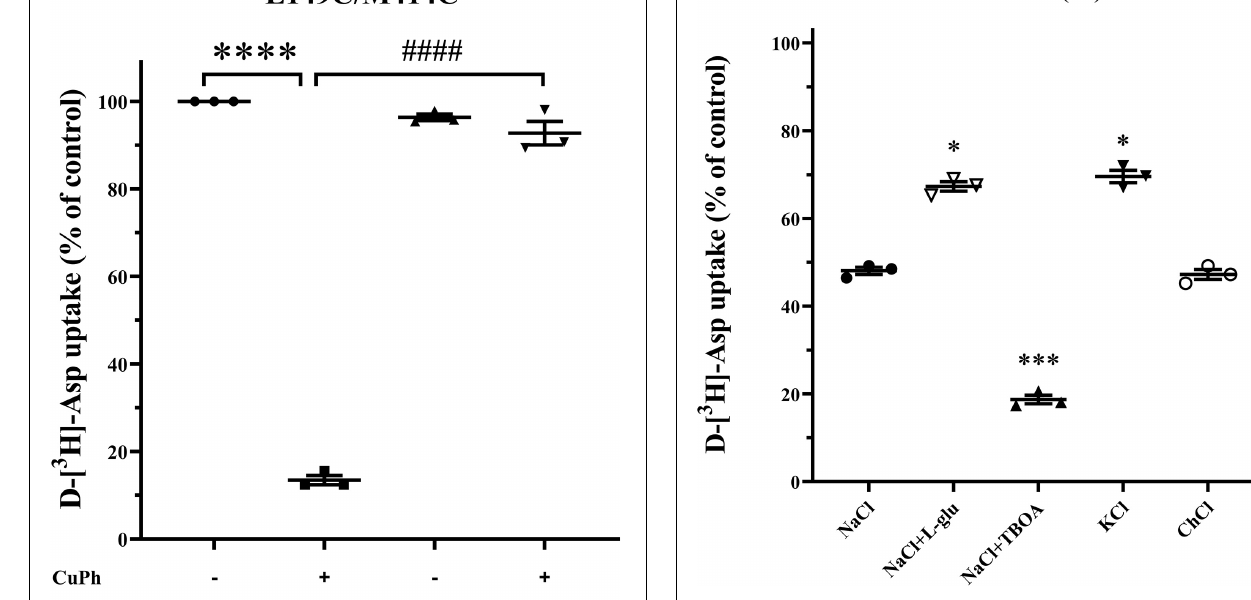
FIGURE 3 | Effect of Dithiothreitol on CuPh-induced inhibition in L149C/M414C double mutants. HeLa cells expressing L149C/M414C were preincubated for 5 min in the presence and absence of 400 µ M CuPh and then incubated with or without 20 mM DTT. Transport of D-[ 3 H]-aspartate was then determined. Transport activity of L149C/M414C is normalized for that of CL-EAAT2 without CuPh and DTT. Data are the means ± S.E. representative of at least three separate experiments in triplicate. Values significantly different from those of double mutants with CuPh were determined by one-way ANOVA ( ∗∗∗∗ p < 0.0001; #### p < 0.0001; n = 3).